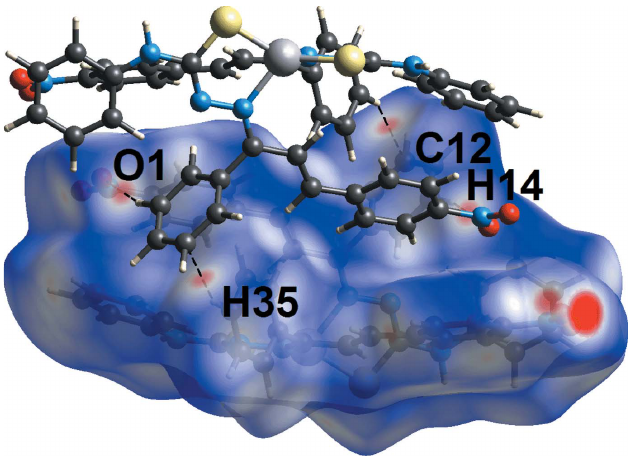
Figure 6 Two views of the Hirshfeld surface mapped over d norm for (I), highlighting weak interactions within red circles (see text).